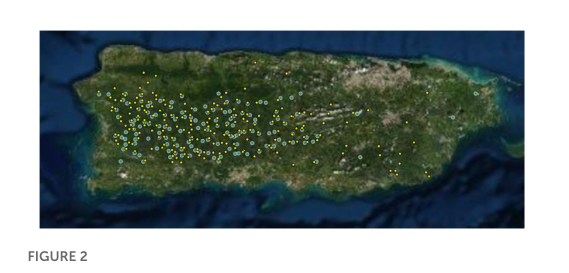
FIGURE2 Spatial distribution of shaded (green circles) and unshaded (yellow circles) coffee farms in Puerto Rico from the Caribbean Climate Hub ( n =